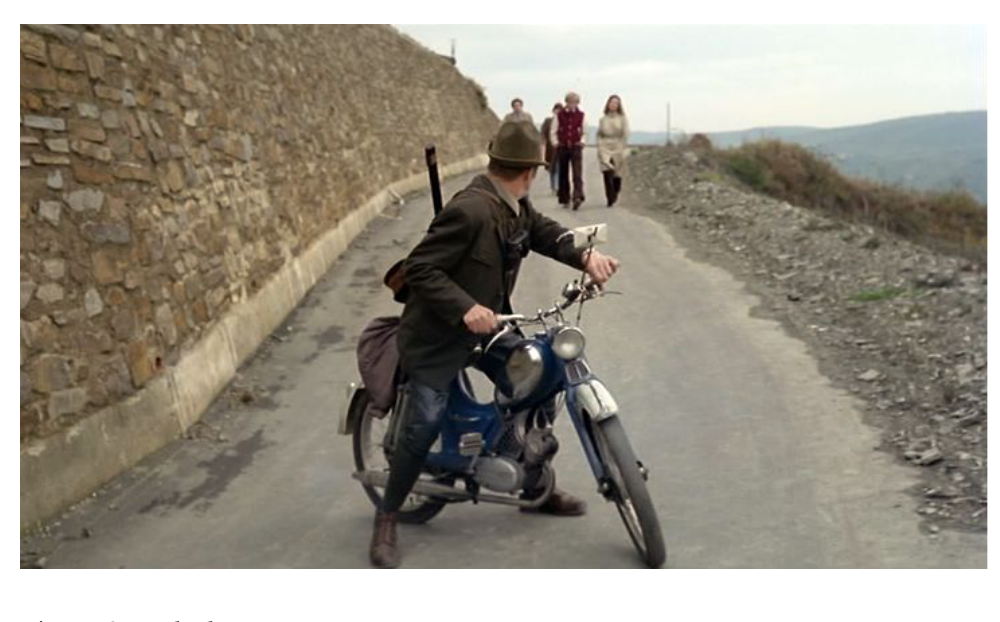
Figure 2: Falsche